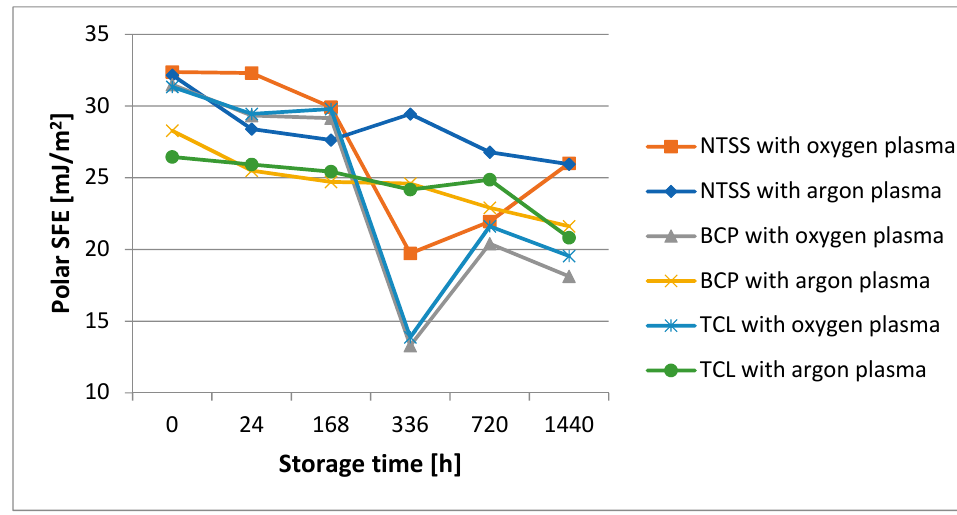
Figure 10. Changes in the polar component of SFE due to storage. Table 2. Contact angle values for water, diiodomethane, and ethylene glycol of samples after plasma activation and during storage.